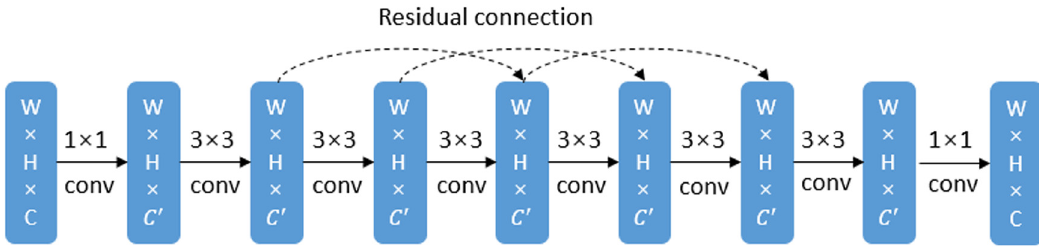
Fig 5. Illustration of the dense block. Dense block is composed of 6 convolution layers to obtain a large receptive field and skip connections are used to avoid the risk of network degradation, gradient vanish and gradient explosion.